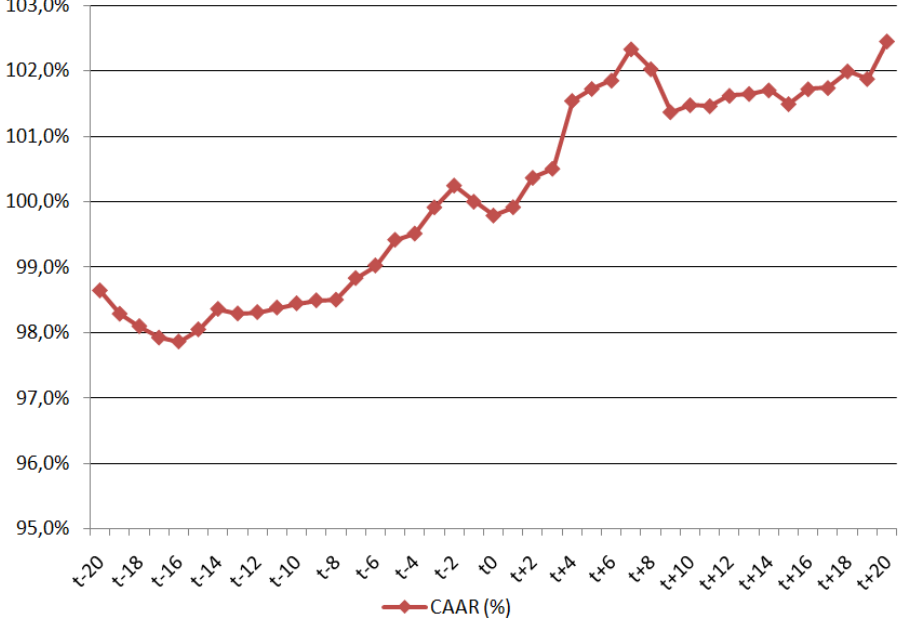
Fig. 1. Daily CAAR for the final sample